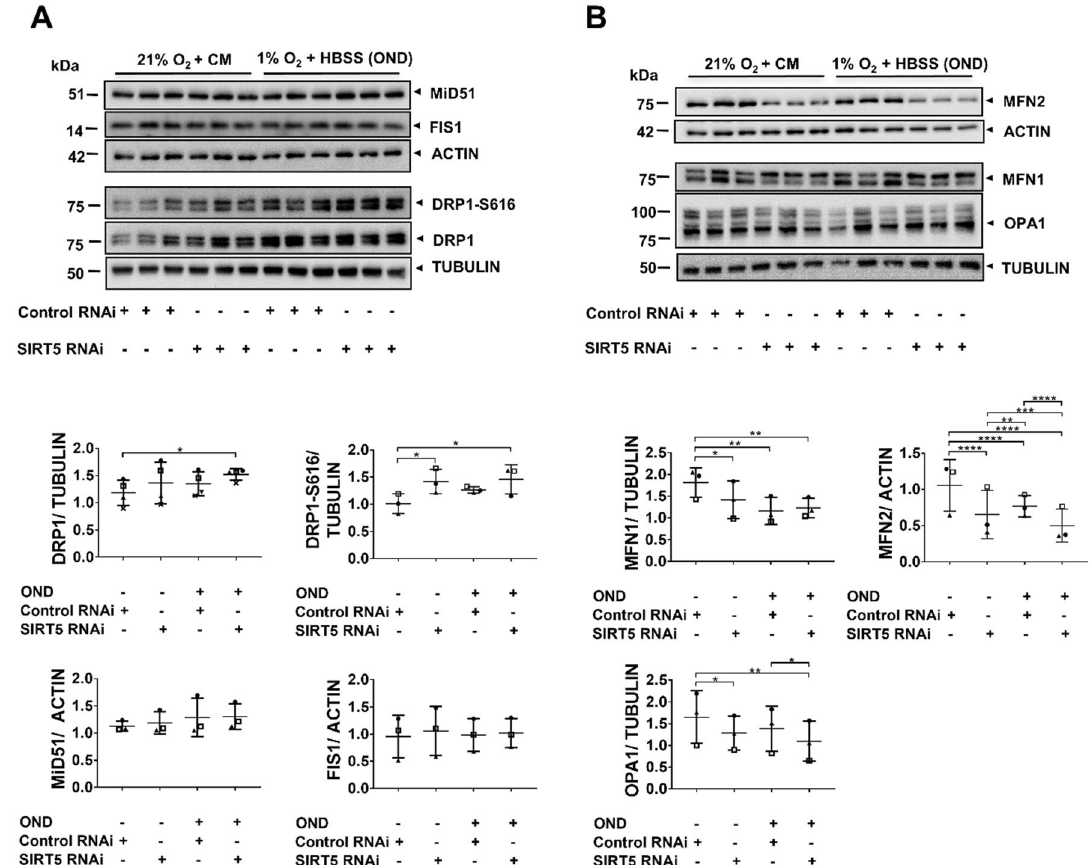
Figure 3. SIRT5 -knockdown disrupts the mitochondrial fission/fusion machinery. hPTECs were transfected using siRNA against SIRT5 or non-targeting siRNA control. Seventy-two hours post-transfection cells were exposed to 6 h of OND (1%O 2 + HBSS) or control conditions [normoxia and complete medium (21%O 2 + CM)]. ( A ) Representative WBs of pro-fission proteins DRP1, DRP1-S616, the DRP1 receptors mitochondrial MiD51 and FIS1. Scatter plots showing densitometry results of DRP1, DRP1-S616, MiD51 and FIS1. DRP1 and DRP1-S616 were normalized to tubulin while MiD51 and FIS1 where normalized to actin. Whole WBs shown in supplementary file (Supplementary Fig. S8c,d). ( B ) WBs of pro-fusion proteins MFN1/2 and OPA1. Scatter plots showing densitometric quantitation of MFN1, MFN2 and OPA1. Data are from three to four independent experiments with n = 3 replicates/group. MFN1 and OPA1 were normalized to tubulin while MFN2 was normalized to actin. Whole WBs shown in supplementary file (Supplementary Fig. S8e). ImageJ was used ***p < 0.001 and ****p <